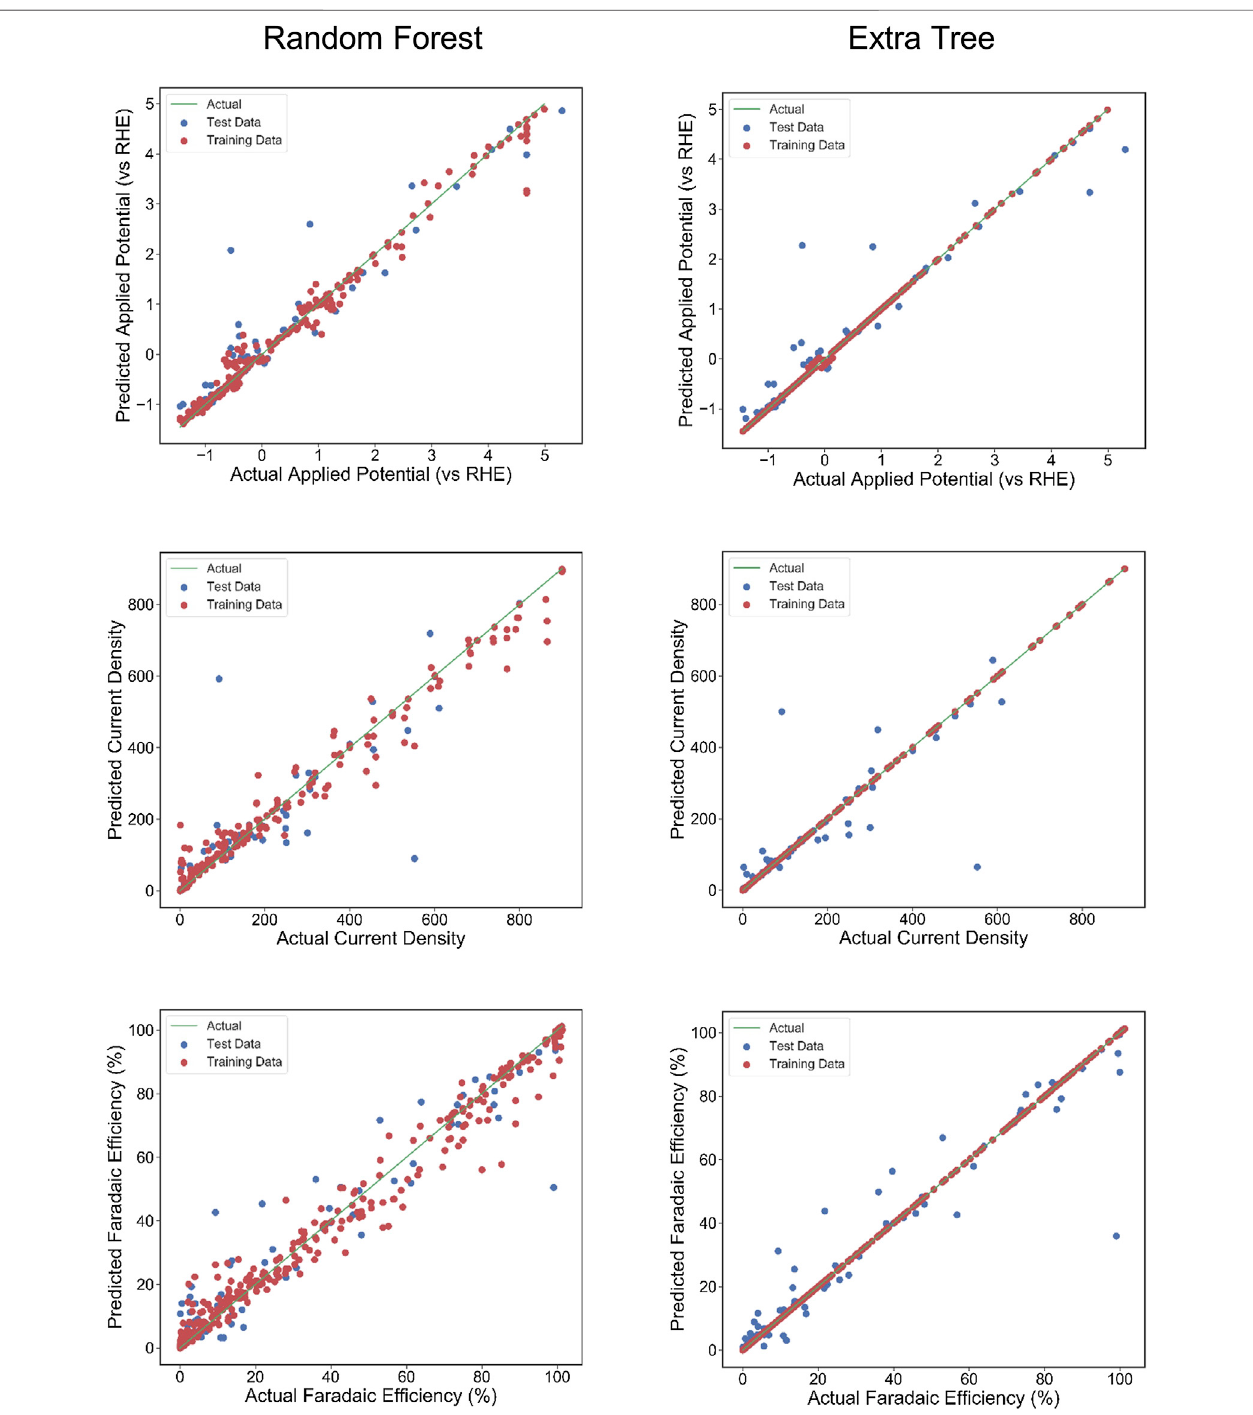
FIGURE4 | The actual Faradaic ef fi ciency,appliedpotential,and Current density valuescompared withthe predicted values using Random Forest regression and Extra Tree regression models. The coef fi cient of determination ( R 2 ) and mean squared error (MSE) are computed to estimate the prediction errors. The test and training points are shown in blue and red, respectively. The perfect correlation line is included for reference as a green line.